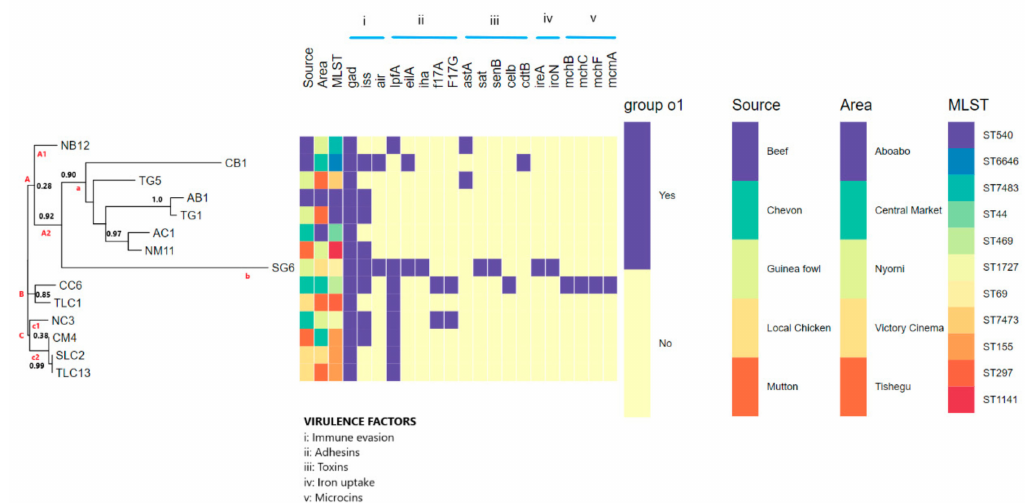
Figure 4. A phylogenomic branch coupled with metadata of isolate information (source, area, sequence types (STs), and virulence factors) showing the relationship between the study isolates ( n = 14) using Phandango. The colour codes di ff erentiated the di ff erent sources, areas, and STs. The virulence factors are represented by Roman numerals I: immune evasion, II: adhesins, III: toxins, IV: iron uptake, V: